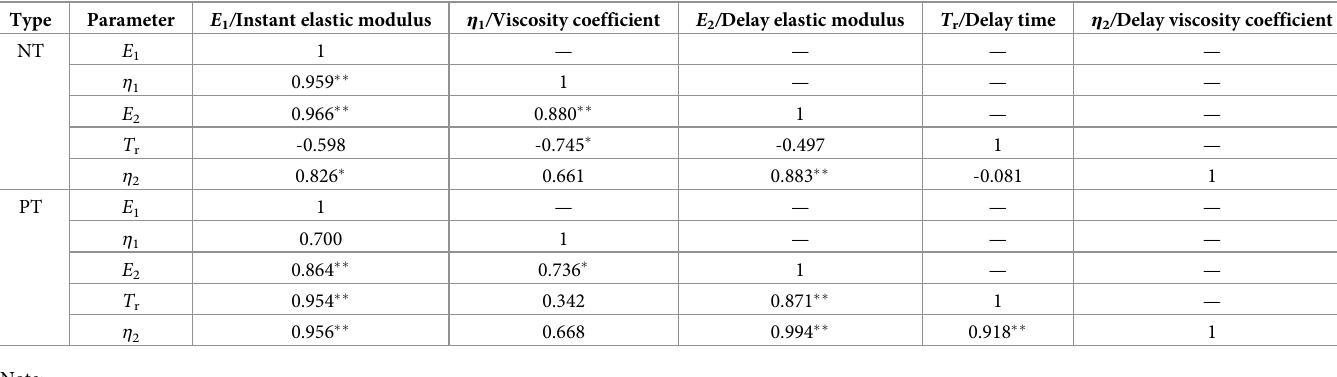
Note: �� indicates the extreme significant difference ( P < 0.01) � indicates the significant difference ( P <